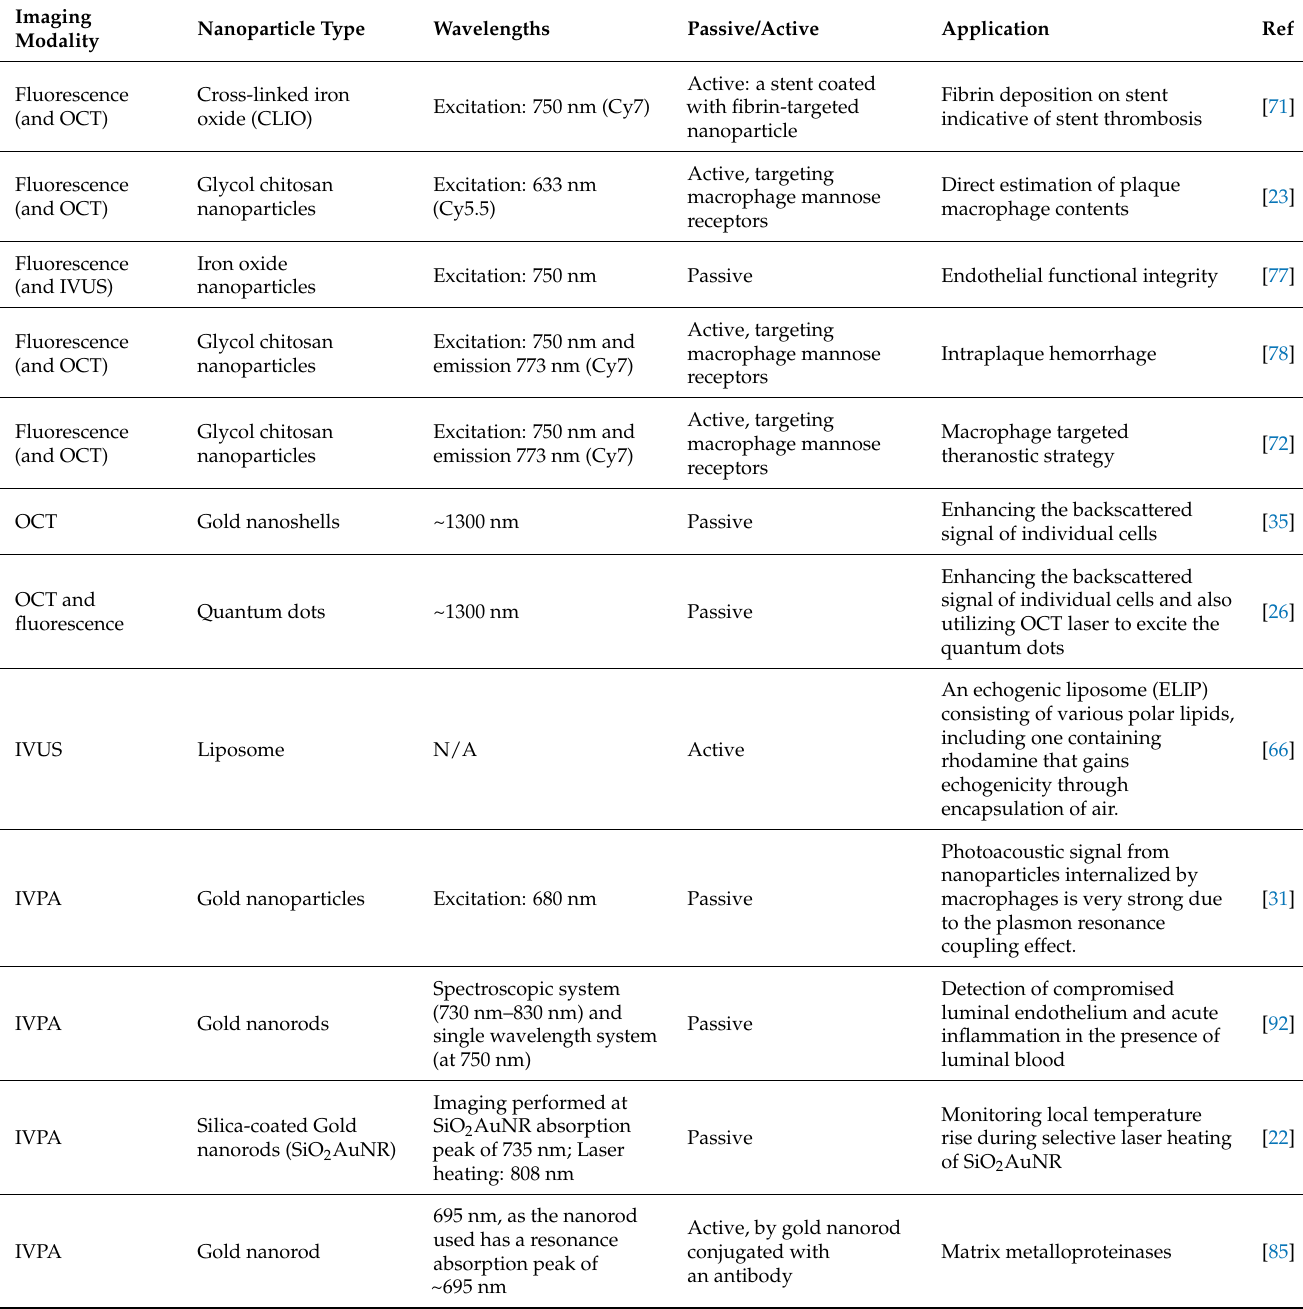
Table 1. Works published to date on the use of nanoparticles for intravascular